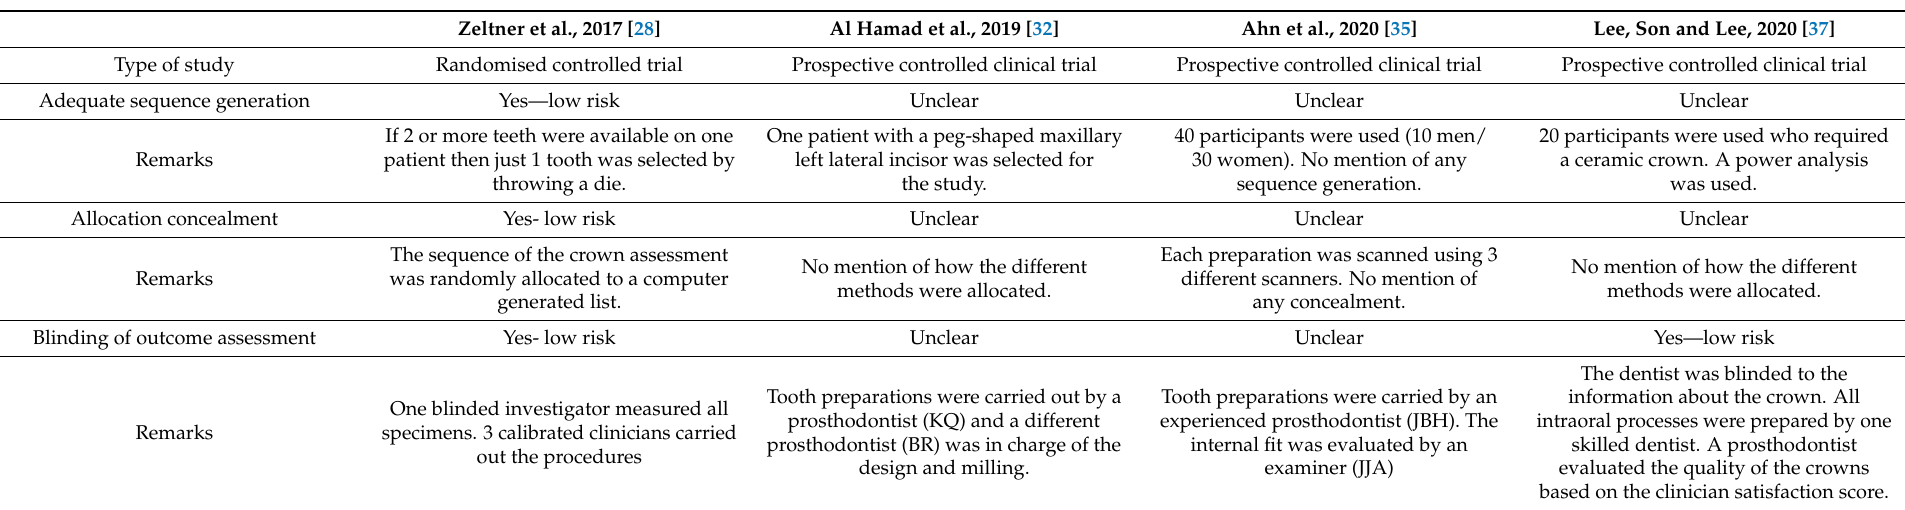
Table 8. Risk of bias table of included